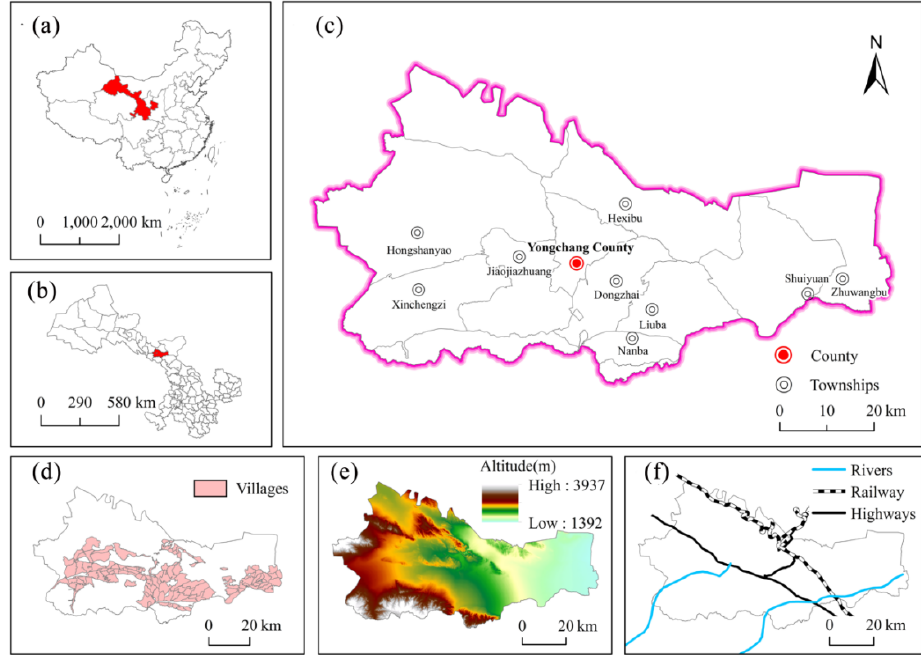
Figure 1. Overview of the study area: ( a ) the location of Gansu Province in China; ( b ) the location of Yongchang County in Gansu Province; ( c ) distribution of land types in townships of Yongchang County; ( d ) distribution of villages in Yongchang County; ( e ) elevation of Yongchang County; ( f ) distribution of main traffic lines and rivers in Yongchang County.